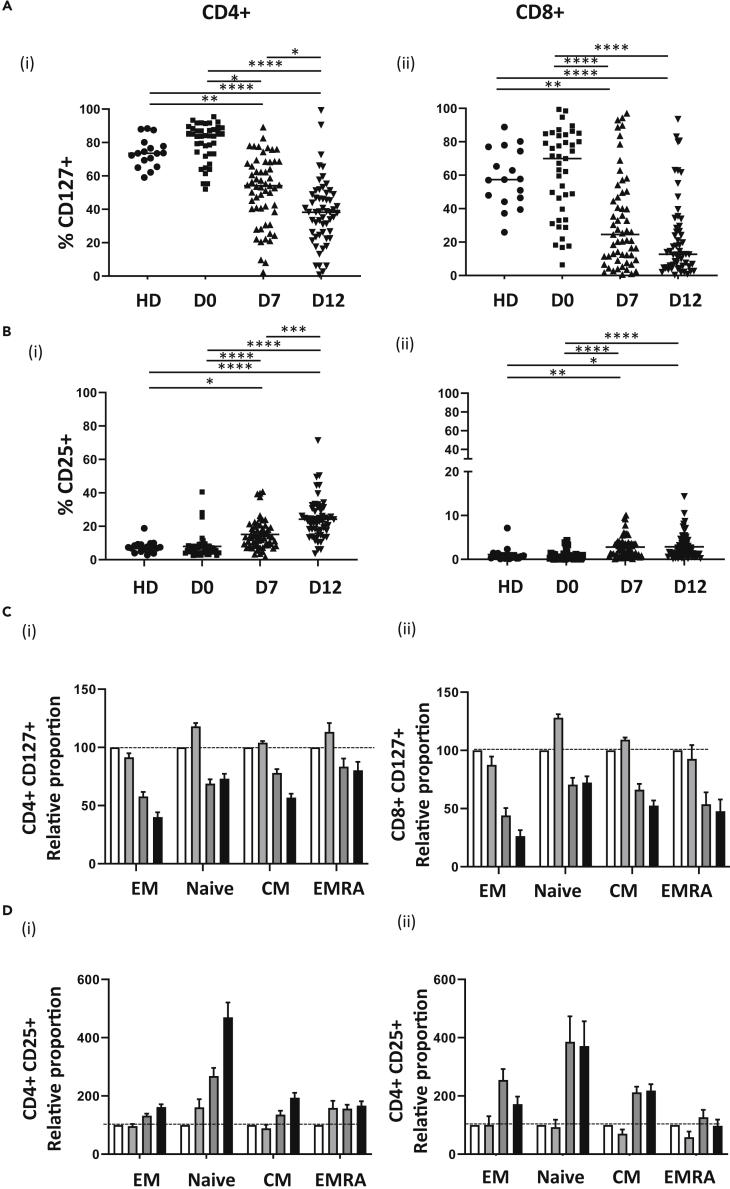
Reciprocal pattern of expression of IL-7R and IL-2Rα during lymphopenia-induced proliferationCD127 (A) and CD25 staining (B) on CD4+ (i) and CD8+ (ii) T cells from healthy donors (HD, n = 17) and autograft patients at day 0 (D0, n = 41) and day 7 (D7, n = 57) and day 12 (D12, n = 56) post-transplant. The mean proportion of CD4+ and CD8+ T cell subsets expressing CD127 and CD25 was calculated for healthy donors (n = 17) and patients at day 0 (n = 41), D7 (n = 57) and D12 (n = 56) post-transplant.The percentage expression for the patient samples at the three time points was then calculated relative to HD (where HD = 100%) for CD127 (C) and CD25 (D) on CD4+ (i) and CD8+ (ii) T cells (HD; white bars, D0; light gray bars, D7; dark gray bars, D12; black bars). Error bars depict standard error mean (SEM). Kruskal-Wallis with Dunn's multiple comparison test was performed, ∗p < 0.05, ∗∗p < 0.01, ∗∗∗p < 0.001, ∗∗∗∗p < 0.0001.